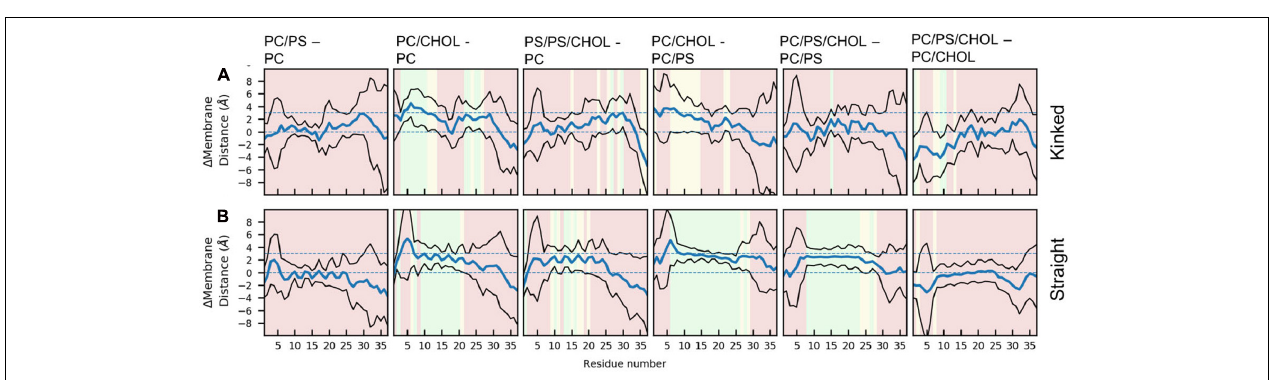
FIGURE 5 | Position of C α of the peptide relative to the phosphate plane for. (A) The kinked conformation (B) straight conformation. Each panel shows the average distance between the IAPP C α and the x-y plane spanned at the average z-coordinate of the phospholipid phosphates (indicated with a dashed line). The lines are colored based on the composition of the lipid membrane in the simulations. The average for the individual simulations are shown in thin lines and the common average in a thicker line. For the sake of comparison, two systems are shown simultaneously. The background color of the plots indicates whether the position on the membrane is significantly different between the two simulation series (green: p ≤ 0.05, yellow: 0.05 < p < 0.10, red: p > 0.10, as explained below).